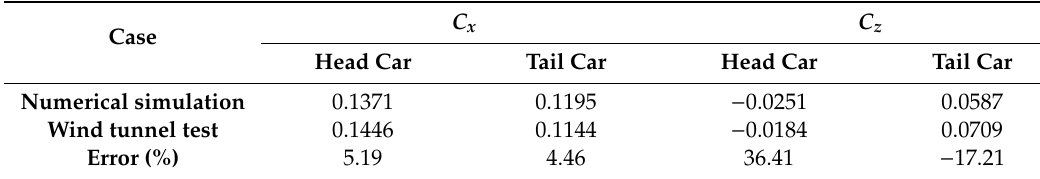
Figure 7. Train model: ( a ) wind tunnel model and ( b ) numerical simulation model. Table 1. Comparison of experimental results and numerical simulation results.